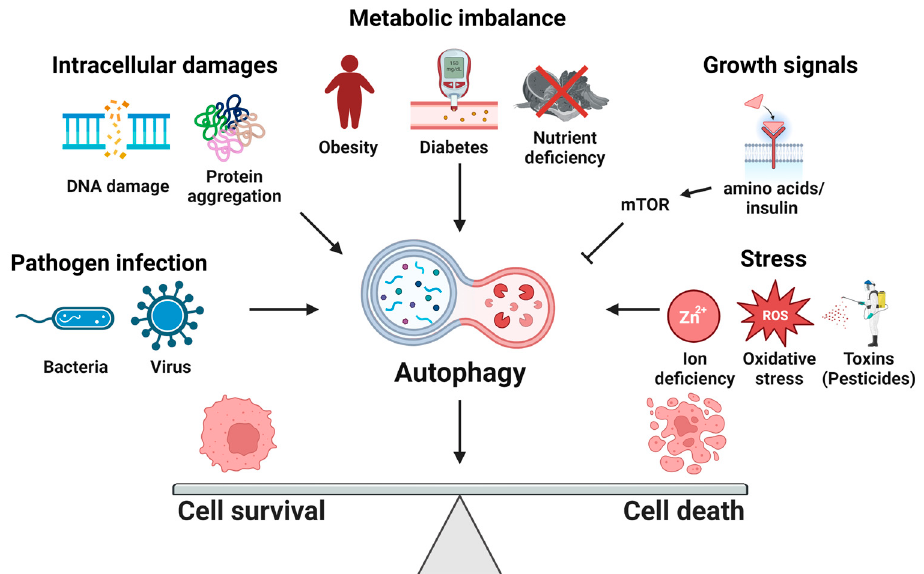
Figure 1. Cell fate can be determined by autophagy regulators under many biological conditions. This figure was created with www.Biorender.com, accessed on 1 March 2023. Biagioni et al. suggested that the autophagoproteasome is suppressed within the ischemic penumbra [2]. The ischemic penumbra is a region in the brain between the dying part caused by ischemic stroke and the salvageable part that still receives blood supply. The overexpression of HSP70 is a well-established biochemical marker of the penumbra area. The region’s autophagy-related proteins, including LC3, increase to keep the system cleared. Indeed, P20S colocalized with LC3 within autophagoproteasome vacuoles,